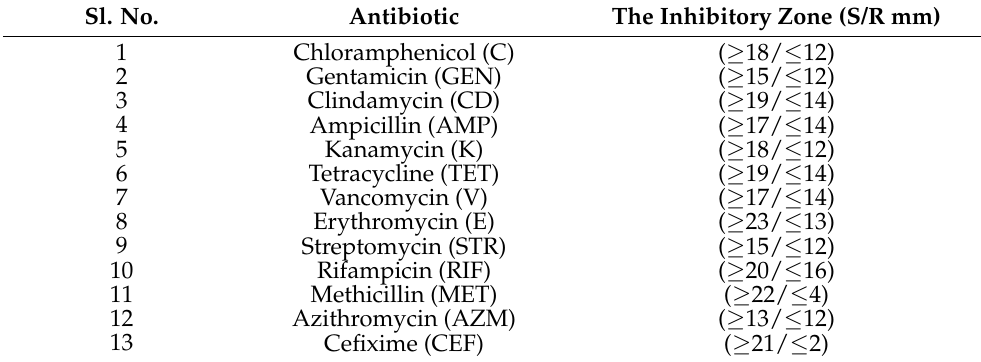
Table 6. Breakpoints of sensitivity/resistance in the mm inhibitory zone of respective antibiotics. Sl. No.